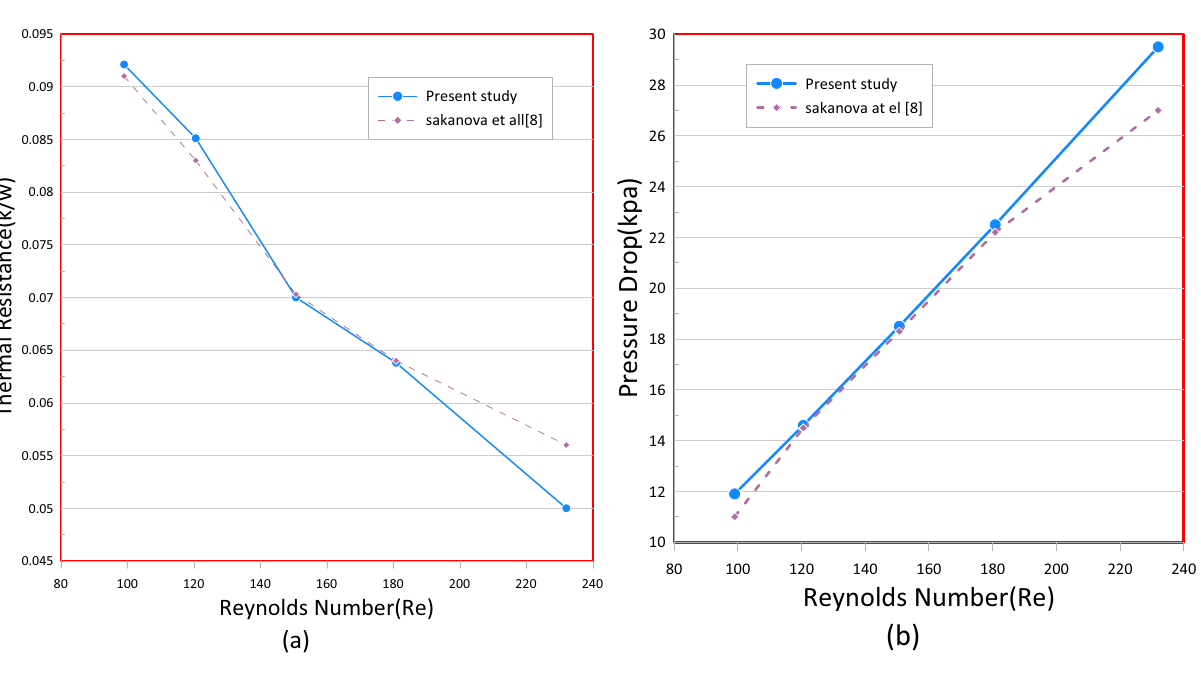
Figure 7. ( a ) Thermal resistance and ( b ) pressure drop dependence on Re for rectangular MCHS using pure Velocity contour characteristics. Figure 9 demonstrates that the velocity distribution and magnitude for a rec- tangular and a wavy channel with different amplitude along y-axis (A = 0, 0.15, 0.2 and 0.25) with Reynolds number Re = 800 and Ag (7.5%) as a coolant. Because of its wavy structure, the velocity of the fluid will increase with the increase in the amplitude of the wave, as it reached in the rectangular channel (0.49 m/s) and in the wavy shape it reached (0.65, 0.72, 0.81) m/s according to the wave amplitude (0.15, 0.2, 0.25) mm respectively, where the wavy shape gives an activity and an additional boost to the kinetic energy, as a result of reducing the adjacent layer in the waist area which causes an increase the fluid flowing mass thus increases the kinetic.energy of the fluid. The max velocity in the y direction is moved from the centerline to the curvypeaks and the flow next to wavy peaks is accelerated. Therefore, the hydrodynamic and thermal edge layers are becoming thinner. There is thus an improvement in the heat transfer coefficient.